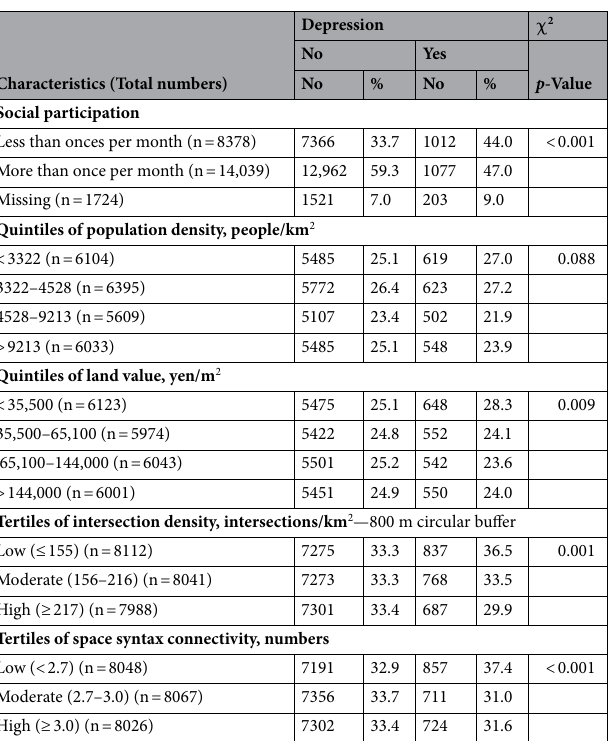
Tertiles of intersection density, intersections/km 2 —800 m circular buffer Low (≤ 155) (n = 8112)